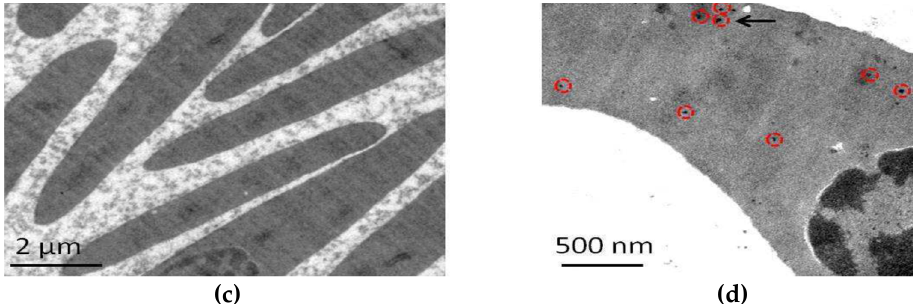
Figure 22. ( a ) Schematic representation showing size-dependent hemolysis of RBCs due to AgNPs. ( b ) Percentage hemolysis vs AgNPs concentrations. TEM images of RBCs ( c ) without and ( d ) with AgNPs (15 nm) treatment. Individual AgNP in ( d ) is outlined with a red circle, while AgNPs are aggregate using black arrows. Reproduced from [213] with permission of the American Chemical Society.